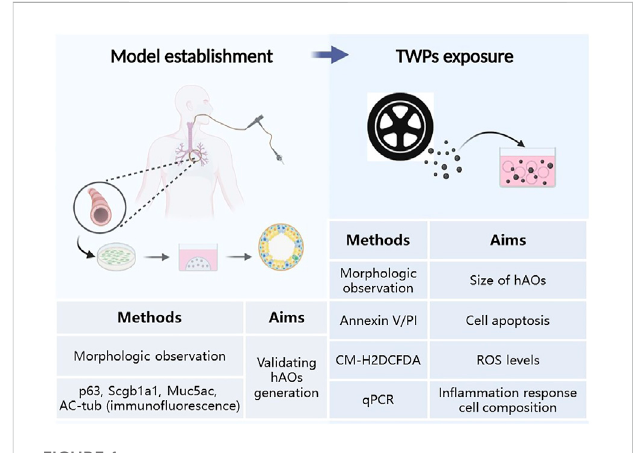
FIGURE 1 Schematic representation and methods summary of our